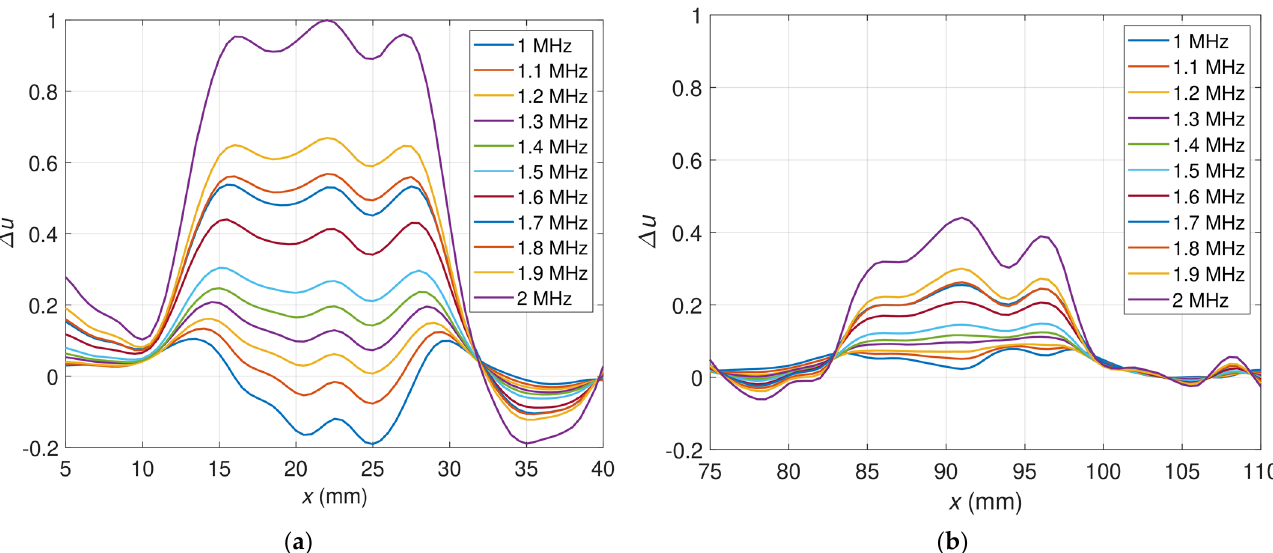
Figure 6. Relative voltages for various excitation frequencies as a function of sensor position ( a ) OF70%; ( b ) OF30%.